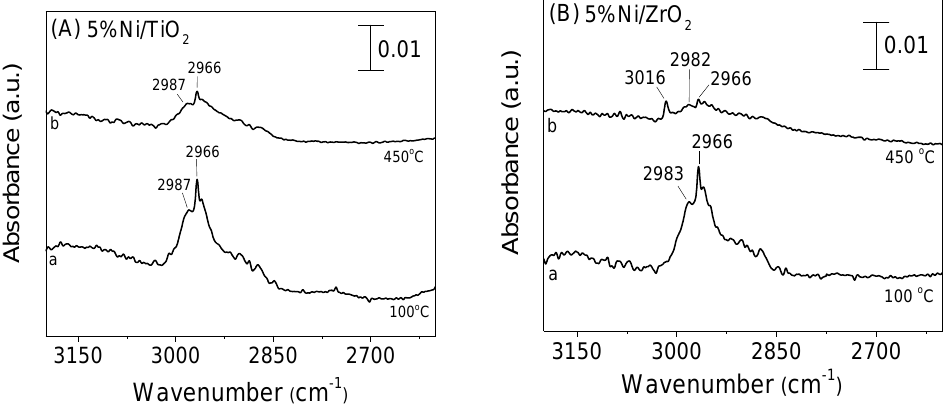
Figure 8. DRIFT spectra obtained in the region 3200 – 2400 cm −1 over the ( A ) Ni/TiO 2 and ( B ) Ni/ZrO 2 catalysts following interaction with 0.5% C 3 H 8 + 5% H 2 O (in He) at 100 °C and 450 °C for 15 min.